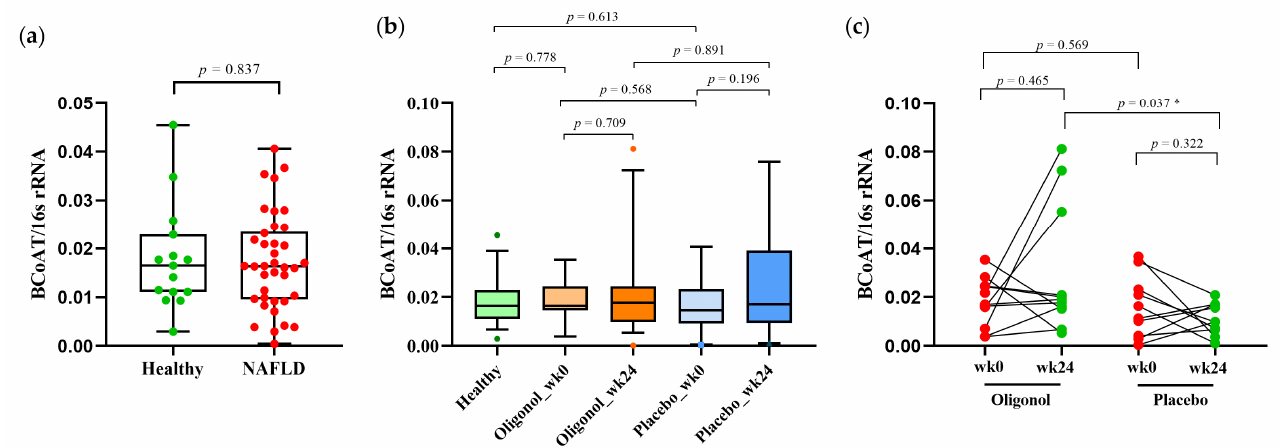
Figure 6. The levels of BCoAT gene in each group of participants ( a ) healthy controls and all patients with NAFLD at week 0; ( b ) the oligonol and placebo groups at week 0 and week 24; ( c ) only patients with decreased MRI-PDFF ≥ 10%. * p < 0.05; NAFLD, Non-Alcoholic Fatty Liver Disease; BCoAT, Butyryl-CoA: Acetate CoA-Transferase; 16 s rRNA, 16S ribosomal RNA; wk0, week 0; wk24, week